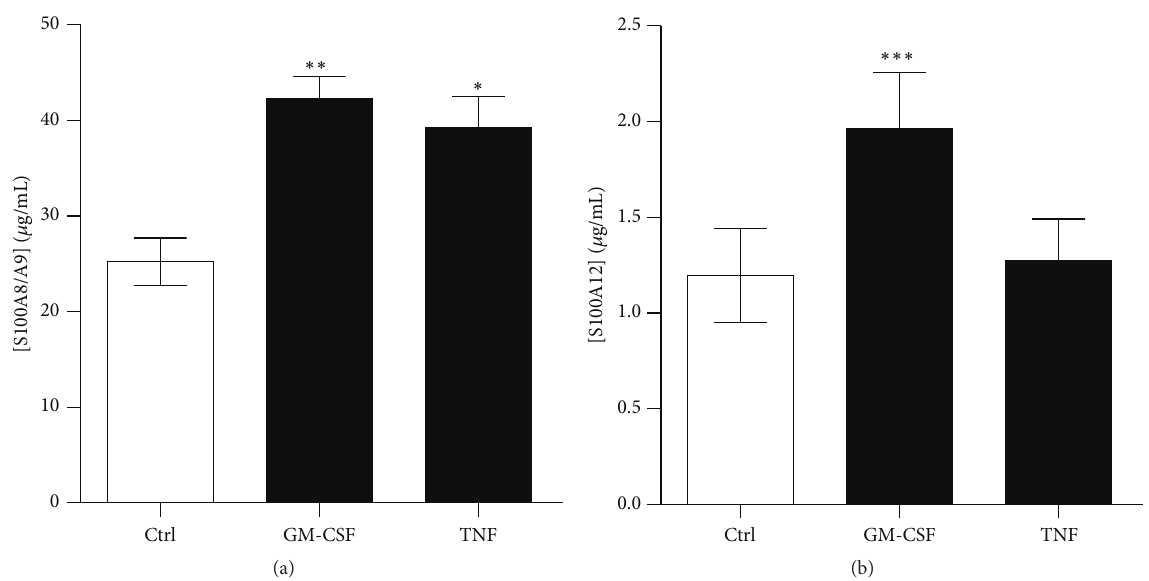
Figure 2: Secretion of calgranulins by neutrophils stimulated with GM-CSF and TNF. Neutrophils were stimulated with 20 nM GM-CSF or 50 ng/mL TNF for 60 minutes. (a) S100A8/A9 and (b) S100A12 were then quantified by ELISA. Results represent the means ± SEM of 5 donors. ∗ 𝑃 < 0.05 ; ∗∗ 𝑃 < 0.01 ; ∗∗∗ 𝑃 < 0.001